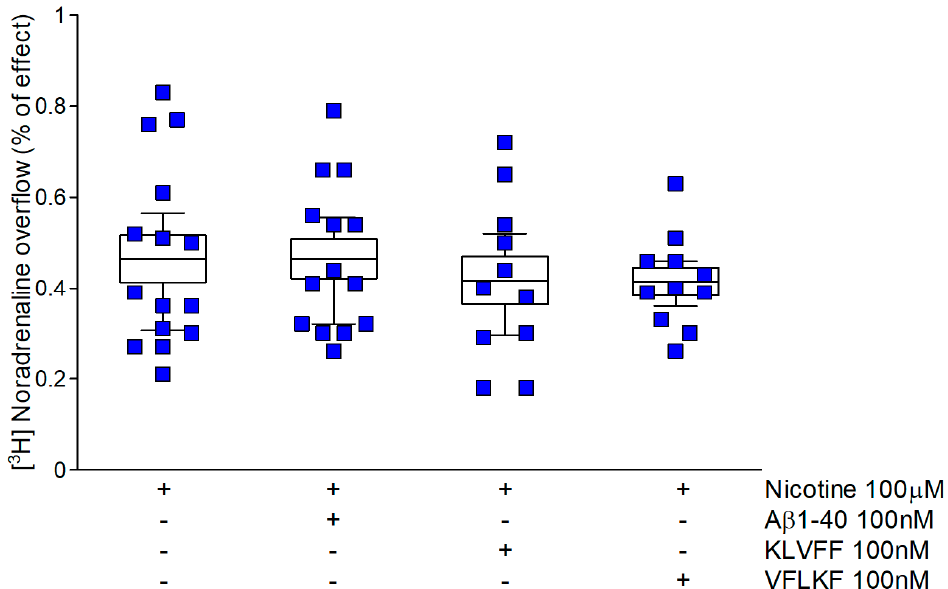
Figure 5. KLVFF is ineffective on the nicotine-induced [ 3 H] noradrenaline overflow from hippocampal synaptosomes: comparison with full-length peptide and scramble fragment. Data are mean ± SEM ( n = 12–15 per group).